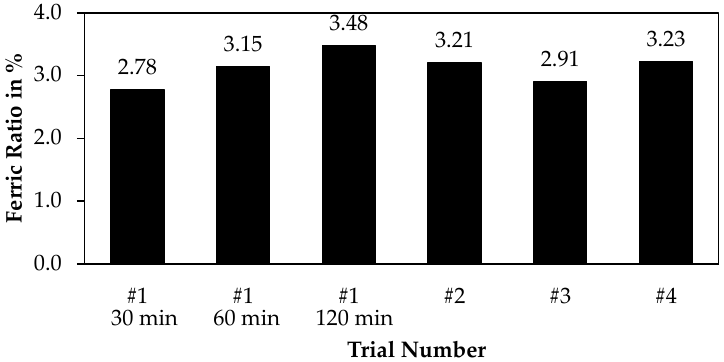
Figure 7. Ferric ratio according to nonstandardized Fe 3+ -leaching trials.